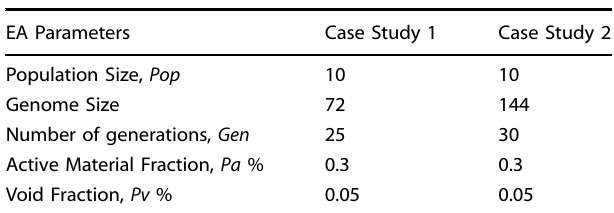
Table 1. EA parameters used in both case studies.